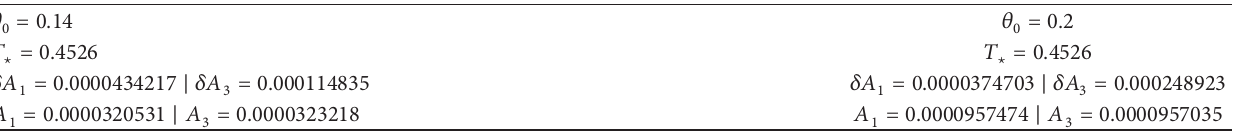
Figure 6: Relation between the minimal area surface and temperature in the fixed charge ensemble for different charges at 𝜃 0 = 0.14 . The red solid line corresponds to the location of the minimum temperature 𝑇 0 ; the dashed lines in (a), (b), and (c) correspond individually to the locations of Hawking-Page phase transition 𝑇 1 , first-order phase transition 𝑇 ⋆ , and second-order phase transition 𝑇 𝑐 . Table 1: Check of the equal area law in the 𝑇 - 𝛿𝐴 plane for different 𝜃 0